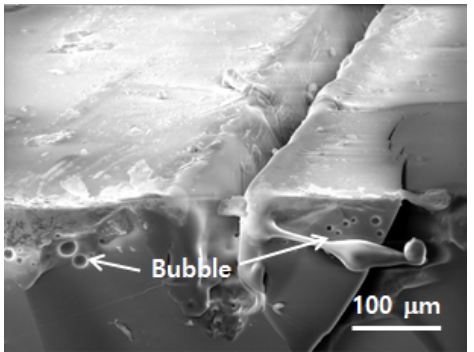
Figure 8. Micron bubbles seen in the heat affected zone (HAZ) (laser power: 2.8 W, scan speed: 20 mm/s, and pulse repetition rate: 30 kHz). Table 4. Process characteristics depending on the laser scanning